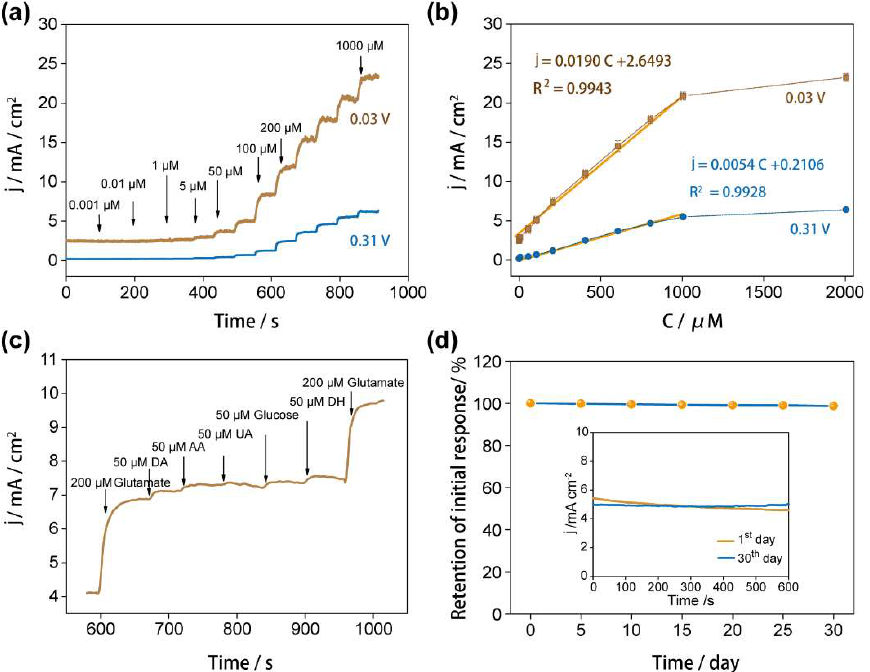
Figure 5. ( a ) Amperometric responses of carbon-based electrode with stepwise addition of glutamate stock solution at +0.03 V and +0.31 V; ( b ) plots of the response currents from ( a ) against the concentration of glutamate; ( c ) amperometric response of carbon foam electrode in successive addition of 200 μM glutamate, 50 μM of different interference species (3,4-Dihydroxyphenylacetic acid (DA), ascorbic acid (AA), uric acid (UA), glucose, and dopamine hydrochloride (DH) in 10 mM PBS containing 4 mM CuCl 2 at 0.03 V; ( d ) long-term stability of the carbon foam electrode measured in 30 days.